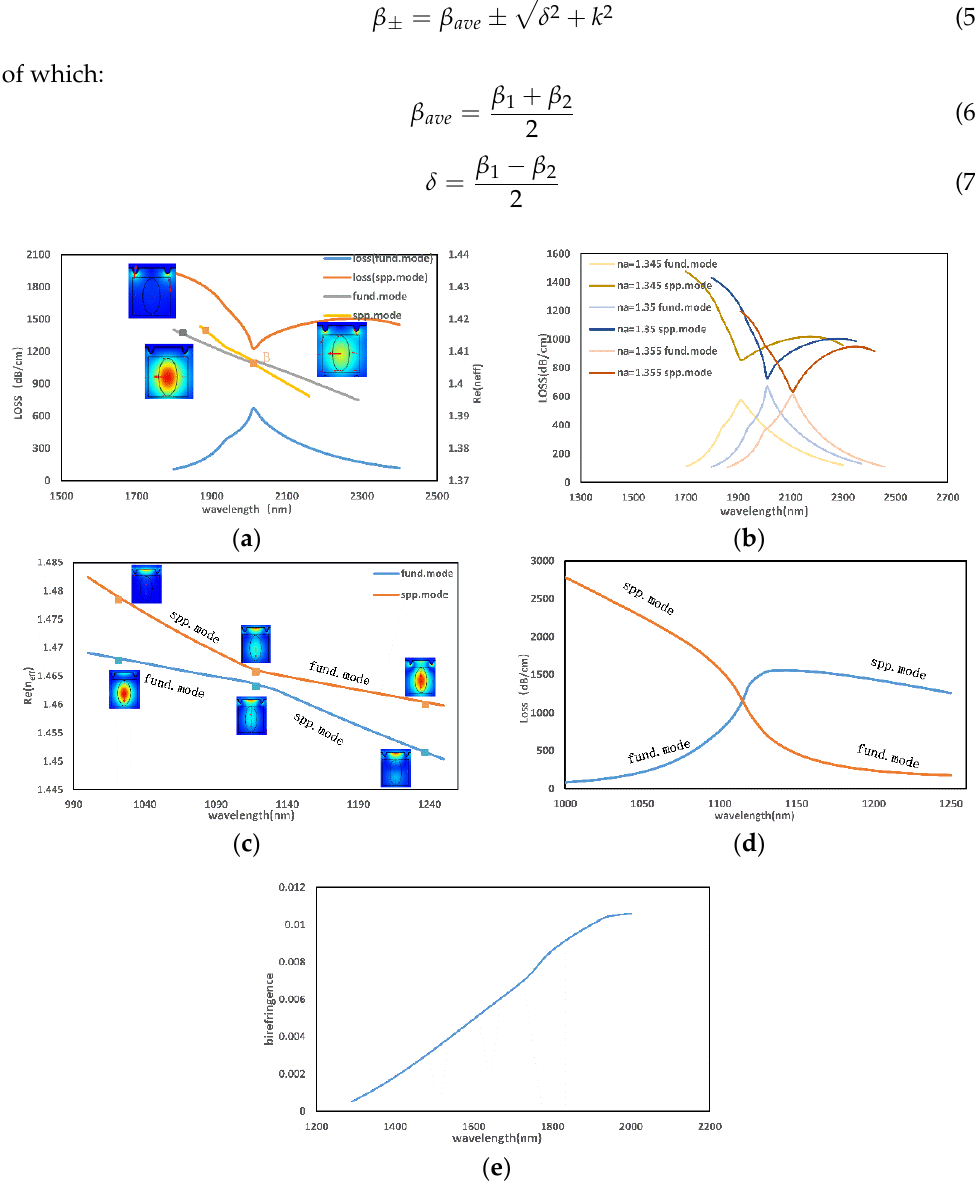
Figure 3. ( a ) is the electric field distribution and dispersion characteristics of the x-polarized of the fund.mode when n a = 1.34; ( b ) is the loss spectrum of x-polarized when n a = 1.345–1.355; ( c , d ) are the Re ( n ef f ) curve and loss spectrum of the y-polarized of the fund.mode, respectively; ( e ) is the birefringence of PCF when n a = 1.34.